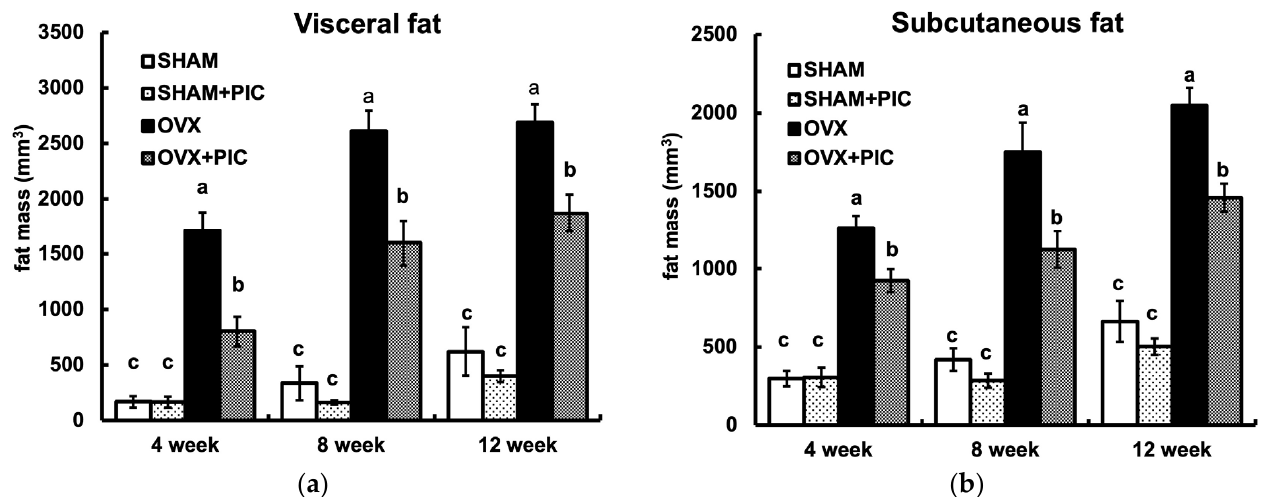
Figure 3. Effects of piceatannol on visceral and subcutaneous fat accumulation. ( a ) Visceral fat mass and ( b ) subcutaneous fat mass. Abdominal fat mass was measured by micro-CT scan analysis every 4 weeks. Visceral fat and subcutaneous fat were evaluated in abdominal regions between the first and fifth lumbar vertebrae. The data are presented as the means ± SE ( n = 5–6 per group), and values with different letters are considered significantly different ( p < 0.05) based on Tukey–Kramer’s test.